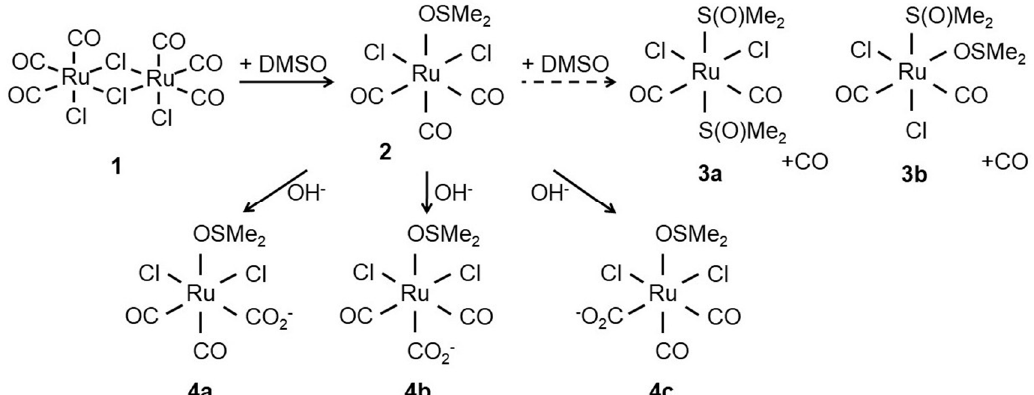
Figure 1. Structure of CORM-2 ( 1 ) prior to dissolution in dimethyl sulfoxide (DMSO). After addition of DMSO, the chloride bridges of the CORM-2 dimer are displaced by attack of DMSO to the Ru(II) ion(s) yielding two identical [RuCl 2 (CO) 3 DMSO] monomers ( 2 ). Next, 2 further reacts with DMSO to yield [RuCl 2 (CO) 2 -(DMSO)] isomers ( 3a, 3b ) with concomitant release of CO. Alternatively, the carbonyl ligands can react with water to give carboxylates ( 4a–c ). Adapted from [24].